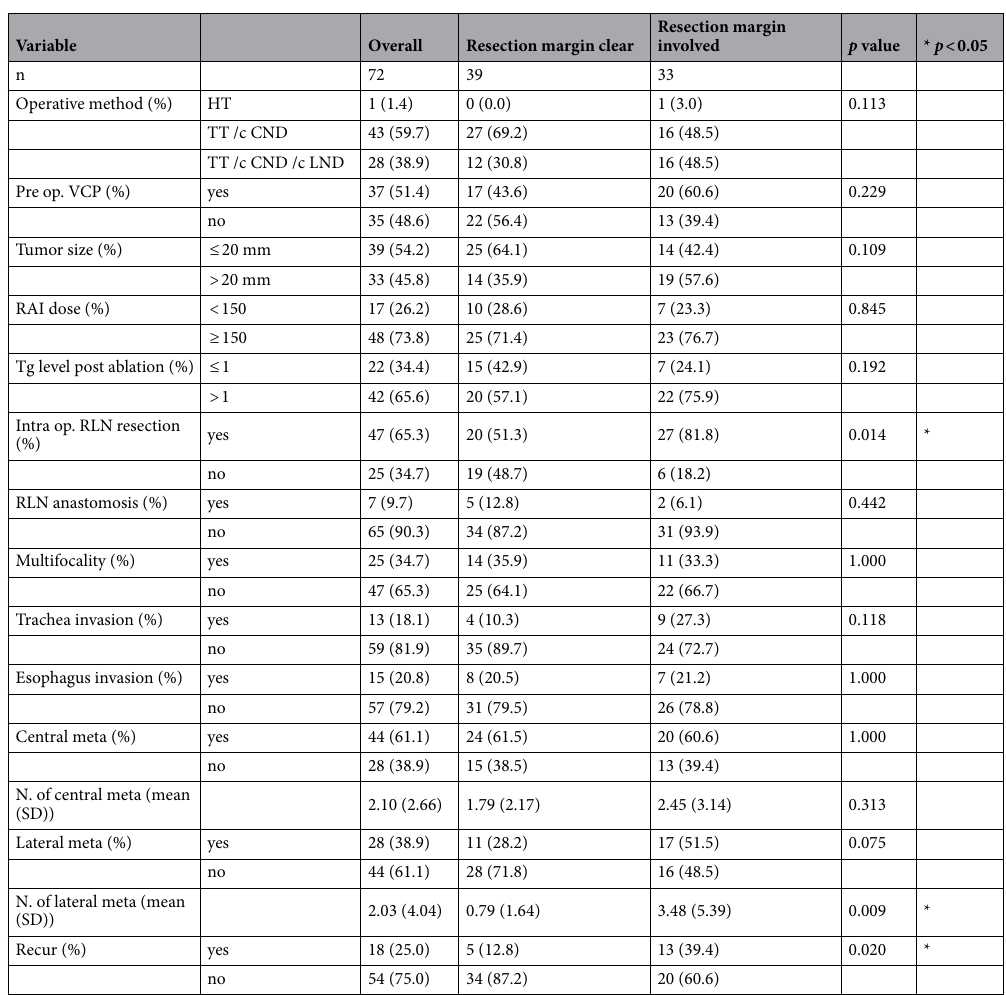
Table 2. Comparison of the resection margin clear group with involved group. † VCP : Vocal cord palsy, RLN : Recurrent laryngeal nerve, ETE : Extrathyroidal extension, SD : Standard